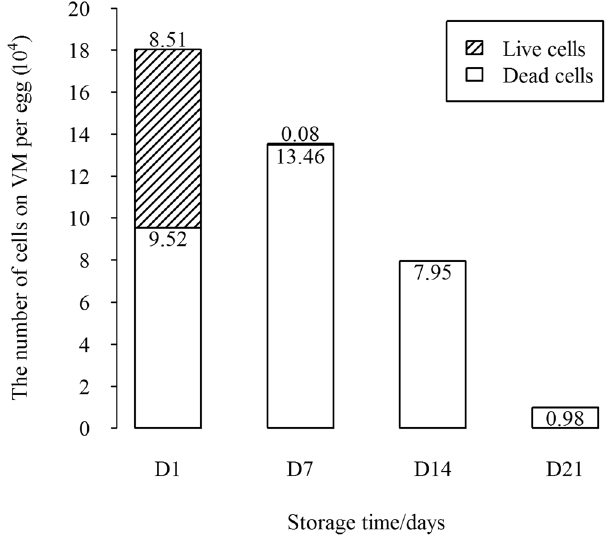
Figure 4. Changes in the live and dead cells of the total cell amount during the storage times of the unfertilized eggs (15 cm 2 ).